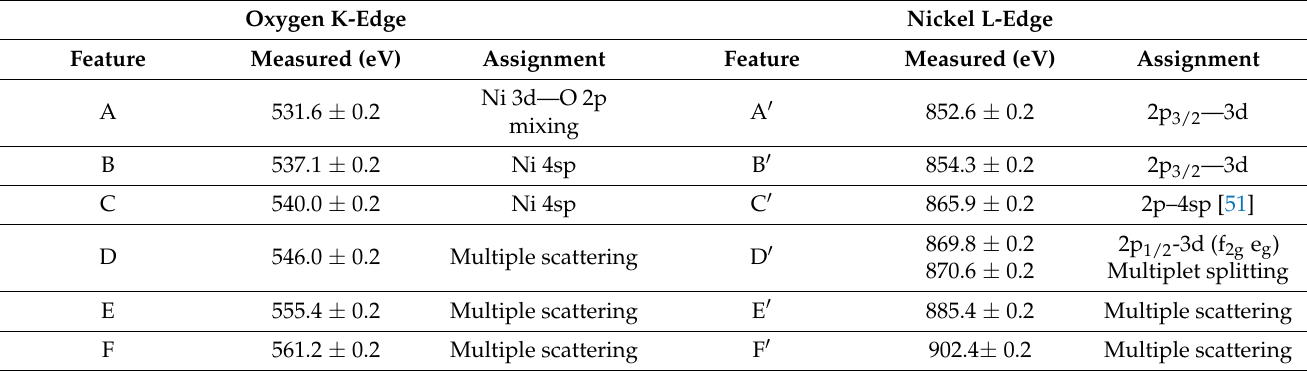
Table 2. Assignment of the measured peak positions for the oxygen K-edge and nickel L-edge NEXAFS spectra of NiO.